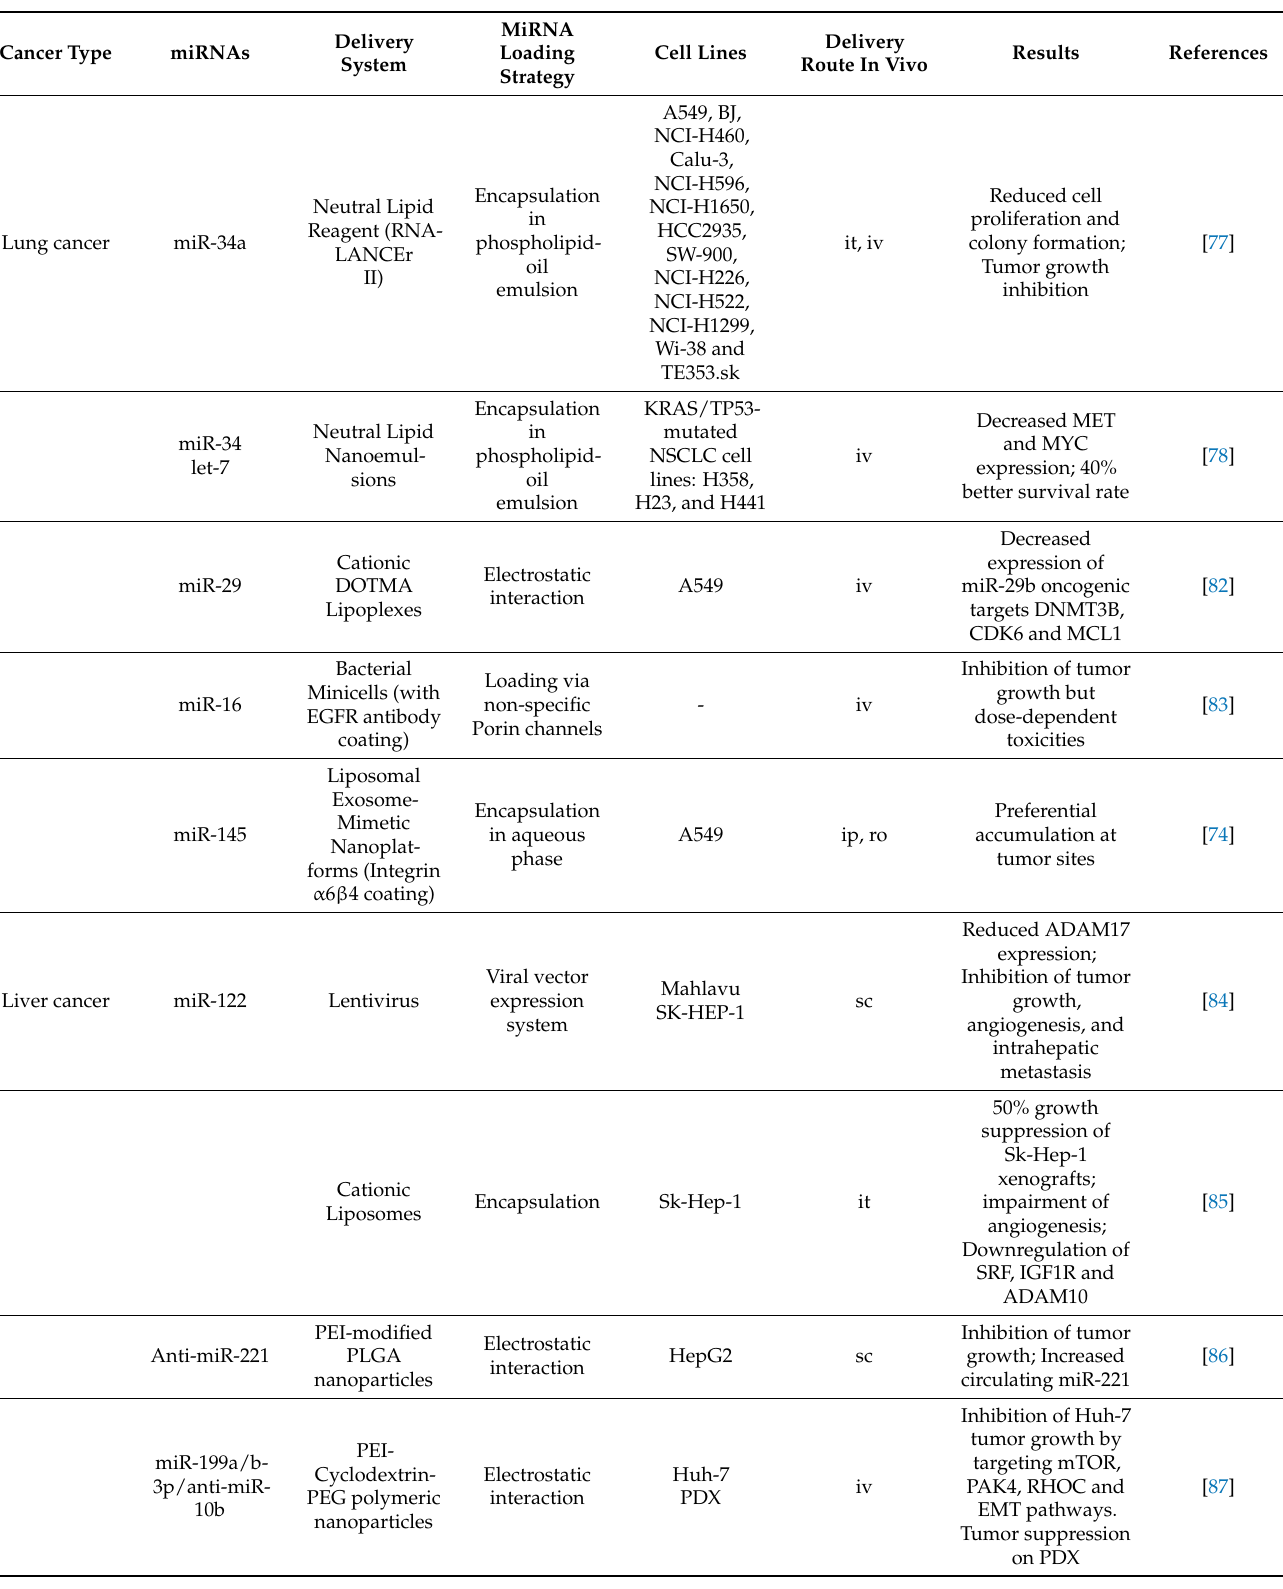
Table 1. Examples of in vitro (cell lines) and in vivo studies (preclinical mouse cancer models) that have been conducted to test miRNA-based therapies in the absence or in the presence of accompanying anticancer